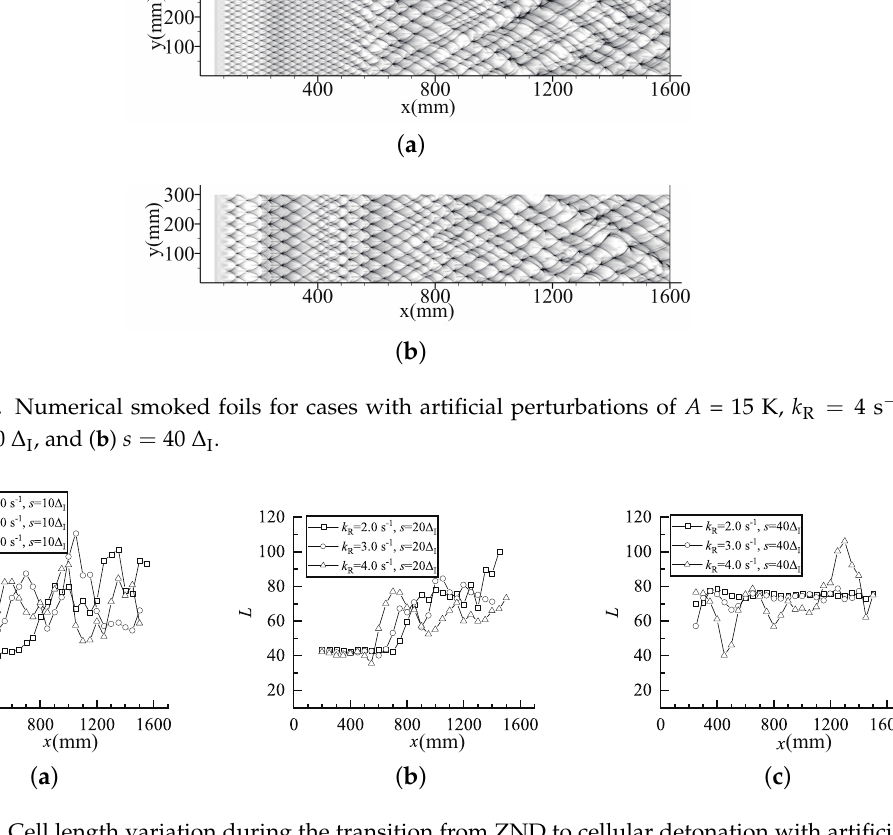
Figure 9. Cell length variation during the transition from ZND to cellular detonation with artificial perturbations, ( a ) s = 10 ∆ I , ( b ) s = 20 ∆ I and ( c ) s = 40 ∆ I .